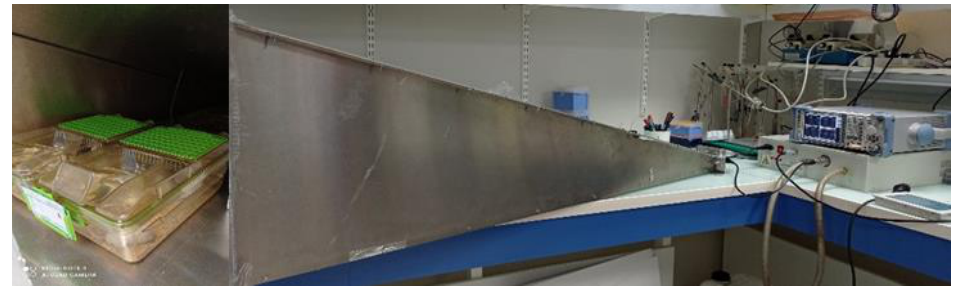
Figure 1. GTEM cell to explore in vivo studies.